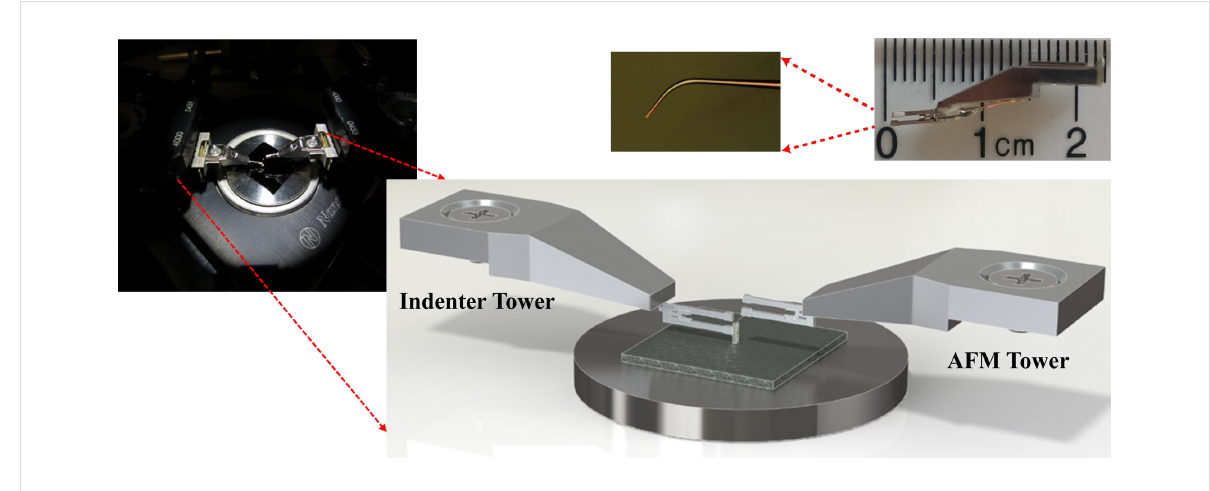
Figure 4: Experimental setup demonstrating the proposed two probe nanoindentation technique.